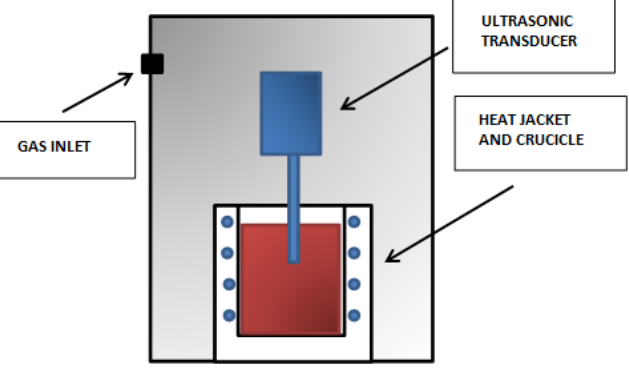
Figure 2. Scheme of experimental setup used by X. Li et al.